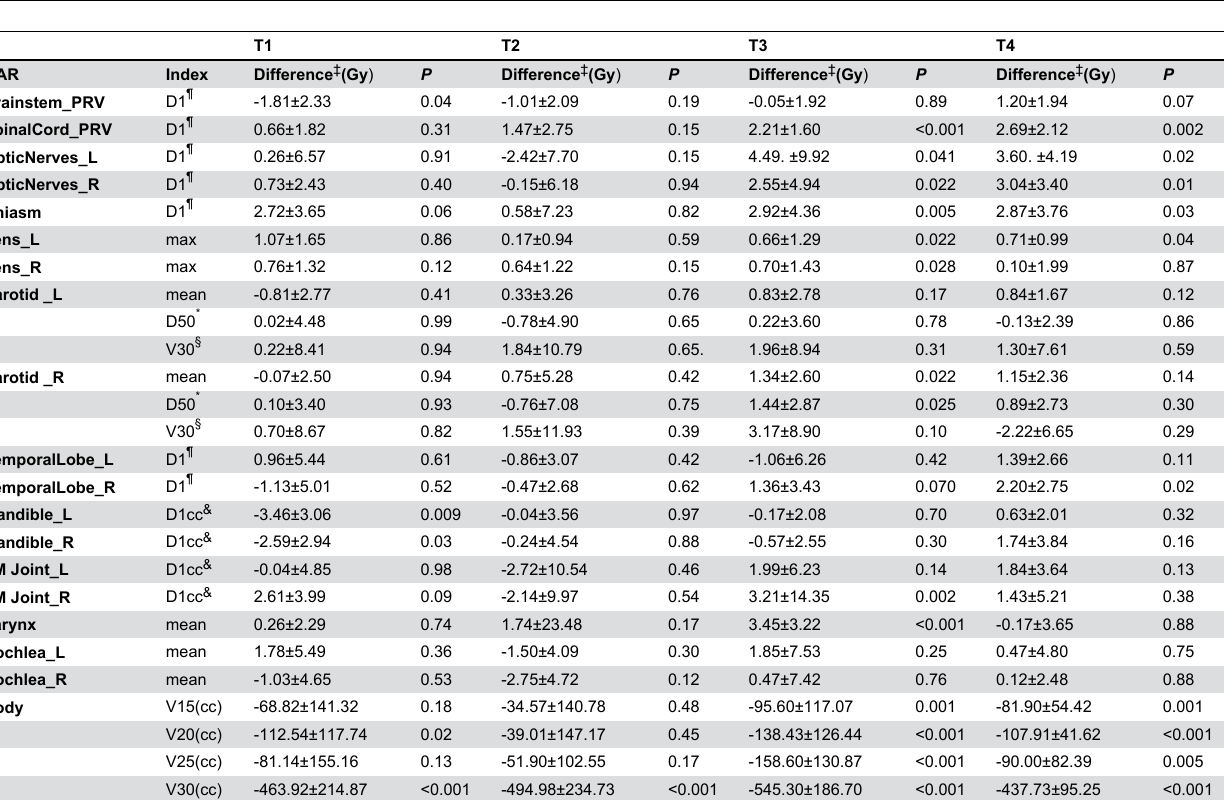
Table 4. Mean differences in dose between s-IMRT and VMAT for the organs at risk (OARs) in 52 NPC patients stratified by T